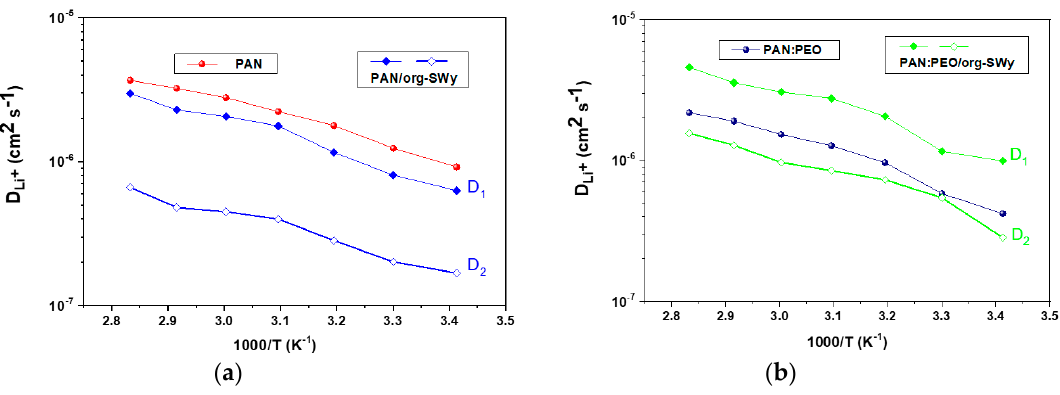
Figure 7. Arrhenius plots of 7 Li self-diffusion coefficients from 20 to 80 °C measured on PAN-based electrolytes ( a ) and blended systems ( b ).